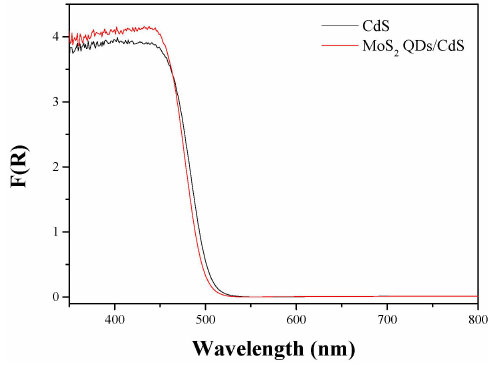
Figure 7. UV-VIS diffuse reflectance spectra (DRS) of CdS and MoS 2 QDs/CdS.